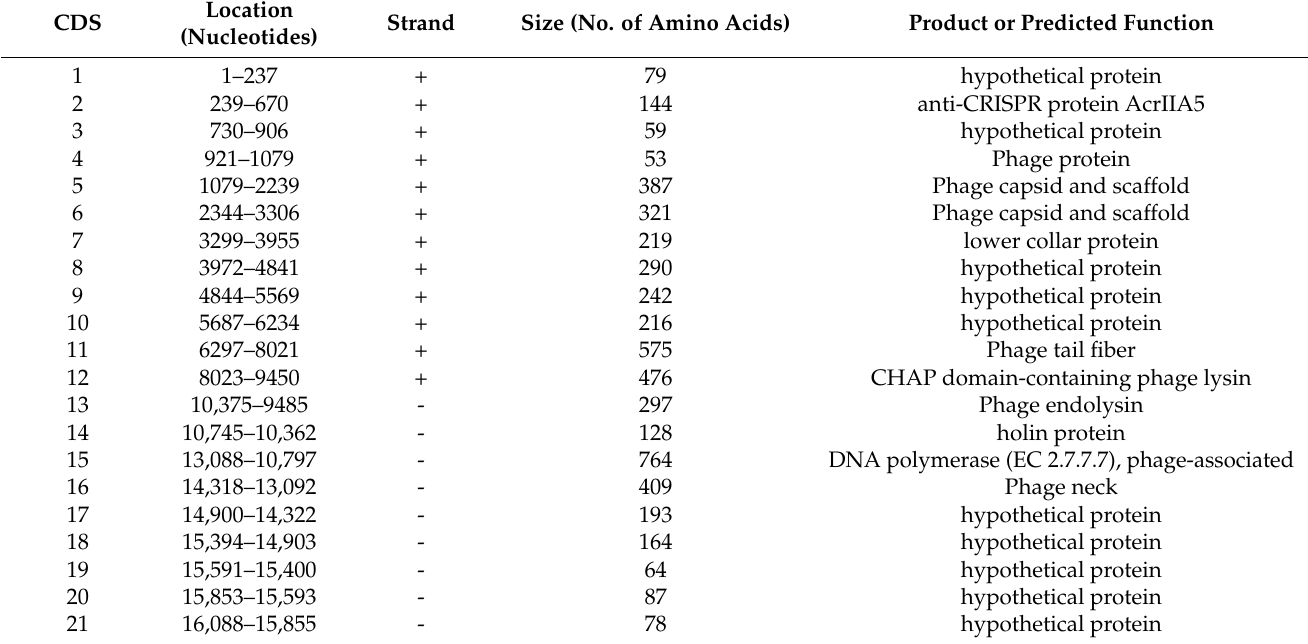
Table 2. Products and predicted functions of proteins encoded by Φ SG005